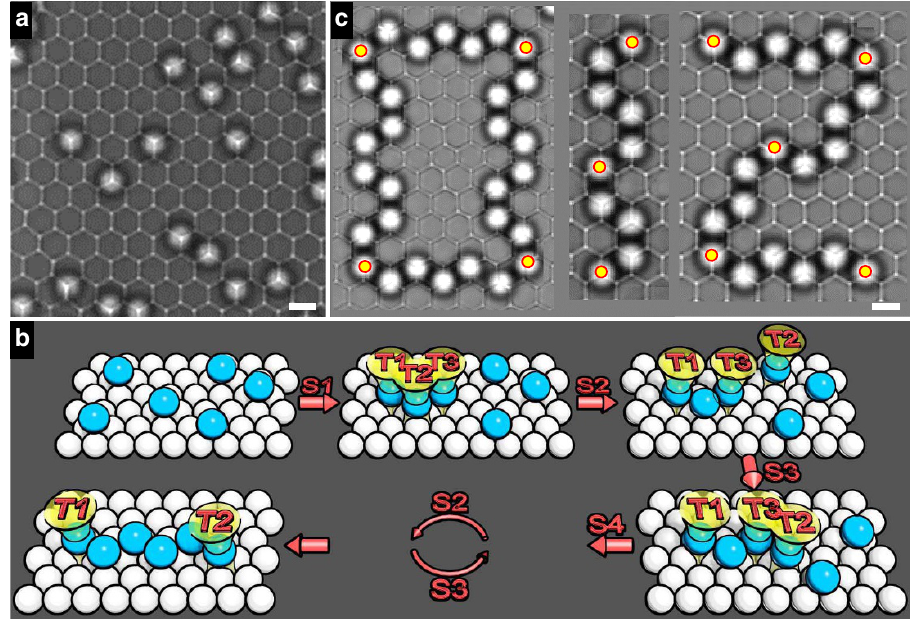
Figure 2 | Vector assembly directed by optical tweezers. ( a ) A typical image of the 2D colloidal system with the focal plane in-between the top particle layer and the bottom monolayer so that the monolayer appears as a uniform honeycomb lattice and the top particles as bright spots. Scale bar, 3 m m. ( b ) The iterative procedure of vector assembly, where tweezers 2 and 3 alternatively act as a shuttle to move wandering particles into position. The final chain is locked down by a mere two optical tweezers. T1 to T3 denote optical tweezers and S1 to S4 refer to assembly steps. ( c ) Vector structures of the